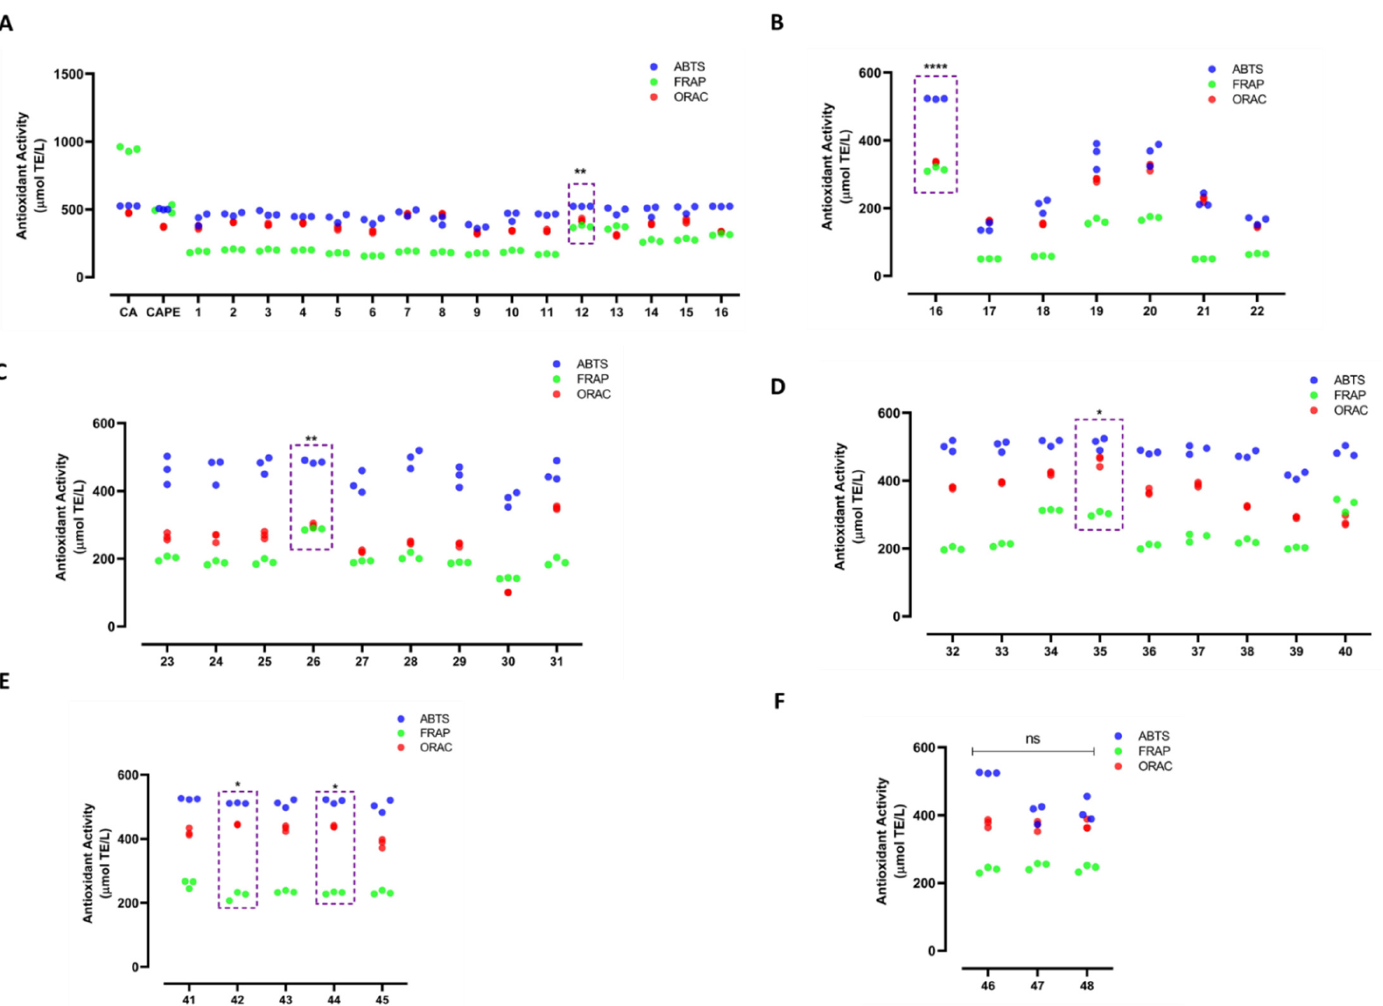
Figure 1. Antioxidant activity of Caffeic acid and CAPE analogs (100 µM) as measured using ABTS, FRAP, and ORAC antioxidant assays. Selective compounds from each series of analogs ( A – F ) with significant antioxidant activities were selected for further studies following statistical analysis. * p < 0.05, ** p < 0.01, **** p < 0.0001, ns: non-significant.